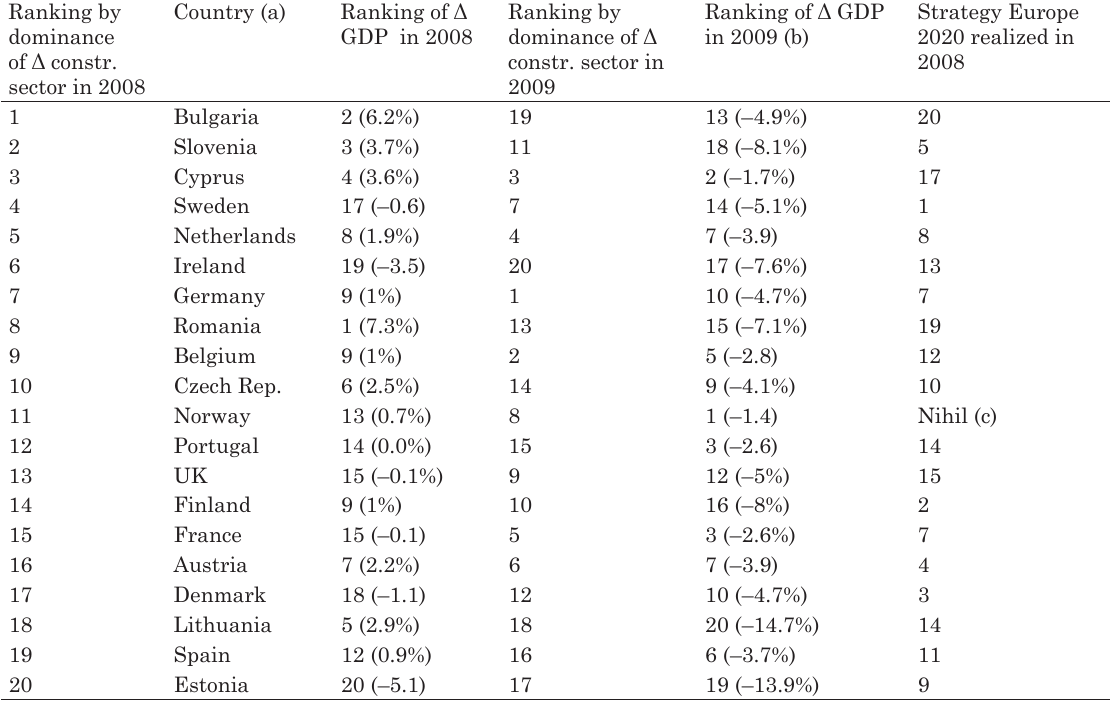
Table 3. The ranking of the construction sector compared to the national GDP and strategy europe 2020 per country Country (a) Ranking of Δ ranking by ranking by GDP in 2008 dominance of dominance of Δ constr. sector in 2008